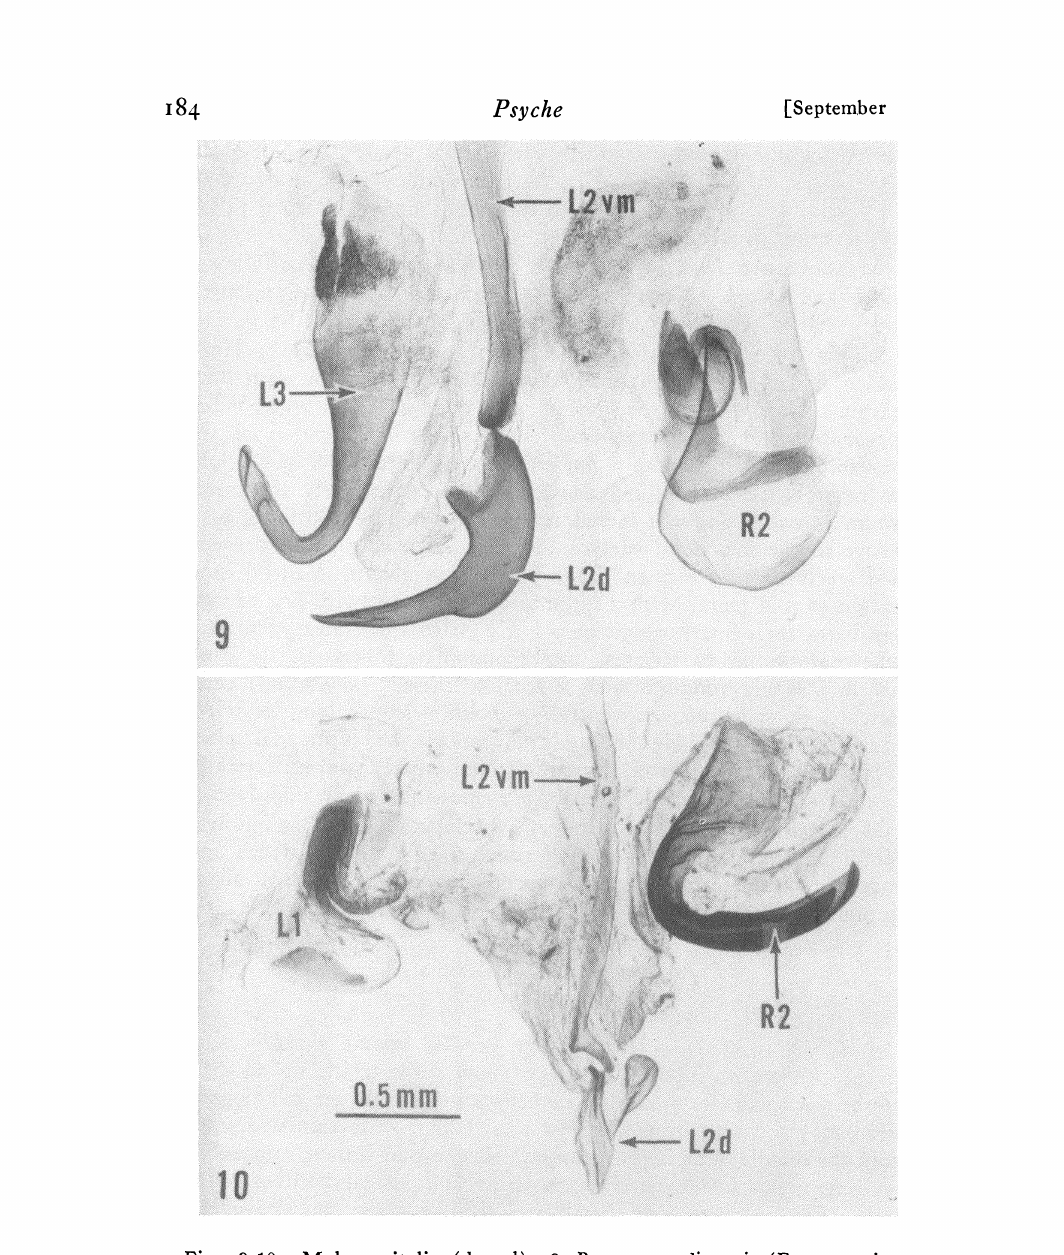
Figs. 9-10. Male genitalia (dorsal). 9. Paramuzoa linearis (From speci- men shown in Fig. 6). 10. Parasphaeria ovata (From specimen shown in Fig. 14). Phallomeres numbered according to McKittrick (1964). (KOH preparations; the phallomeres have been separated somewhat, and flat- tened; Figs. 9 and 10 to same